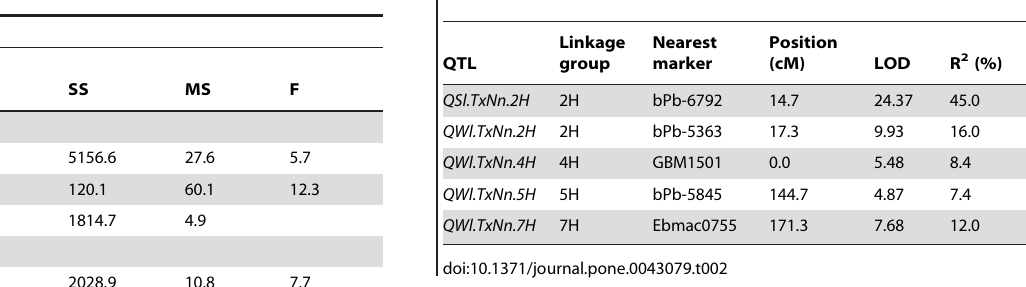
Table 1. ANOVA of salinity tolerance scores in a glasshouse potting mixture experiment and waterlogging tolerance in soil filled tank experiment.